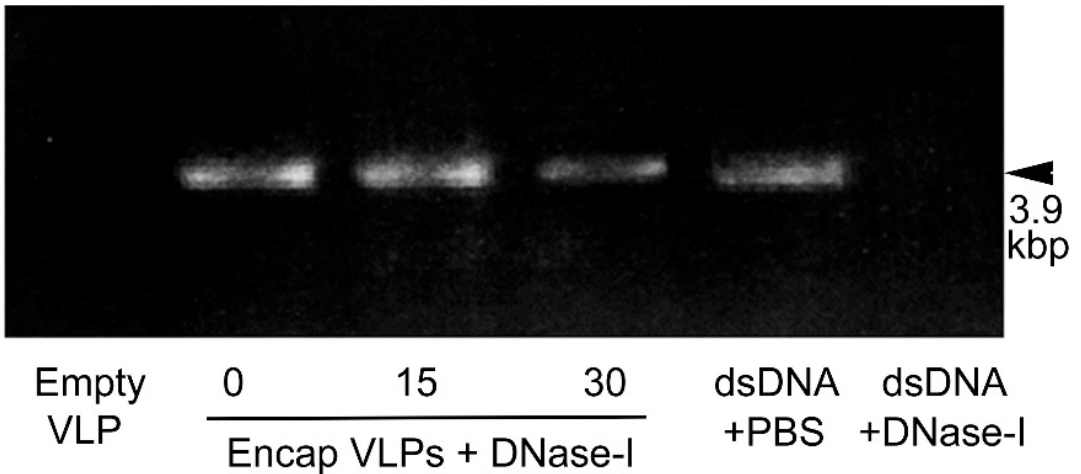
Figure 1. Agarose gel electrophoresis (1%) of dsDNA encapsulated in VLP using disassembling/reassembling method (see Materials and Methods for details). The presence of DNA in the VLP cavity was proved by DNase-I digestion at different times (Lanes 2, 3, and 4). Lane 1 = VLP alone, Lanes 5 and 6 = 5 µg free dsDNA without and with DNase-I, respectively.